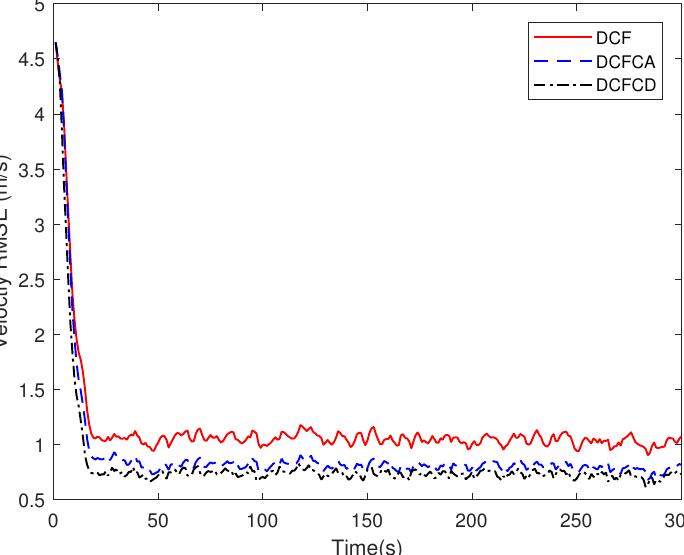
Figure 6. The velocity RMSE for different methods over time with global